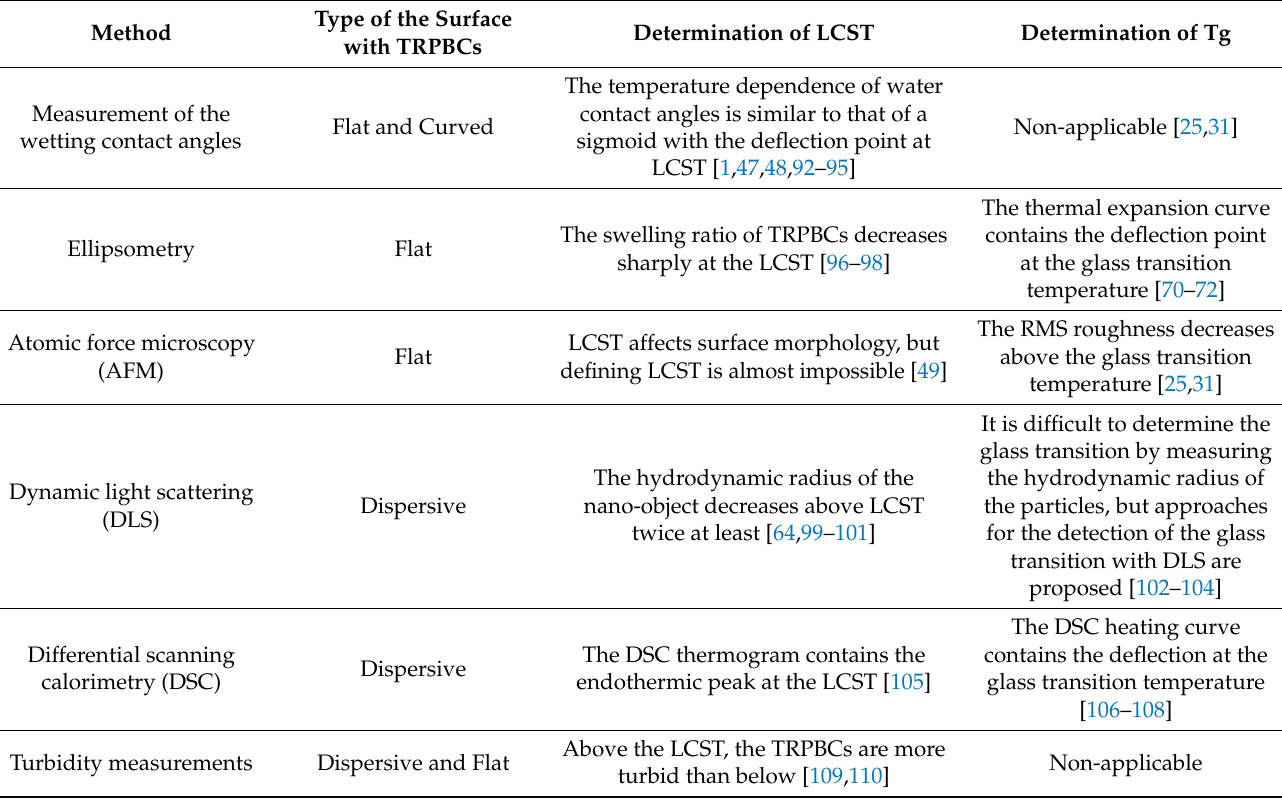
Table 2. Methods for characterization of the TRPBCs and determination of their transition